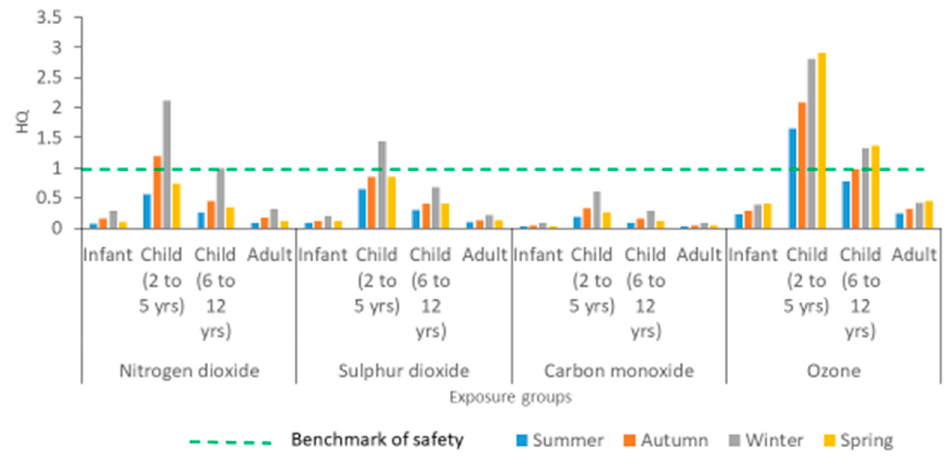
Figure 7. Seasonal non-carcinogenic risk assessment for NO 2 , SO 2, CO, and O 3.